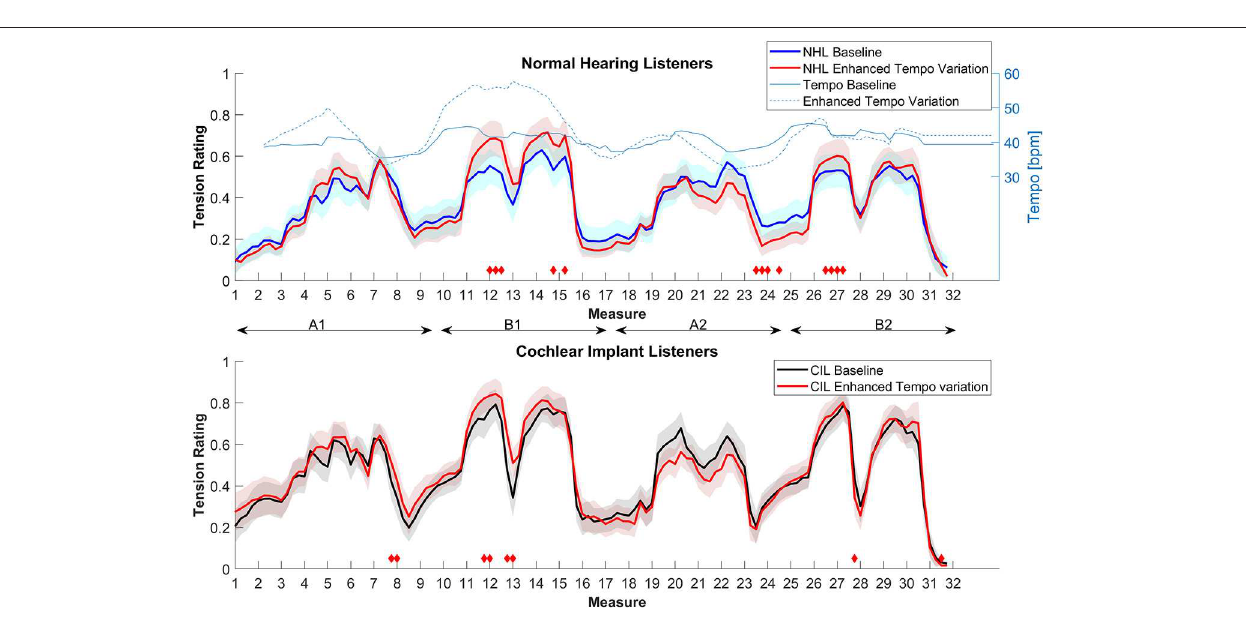
Enjoyment scores did not differ from the baseline for either